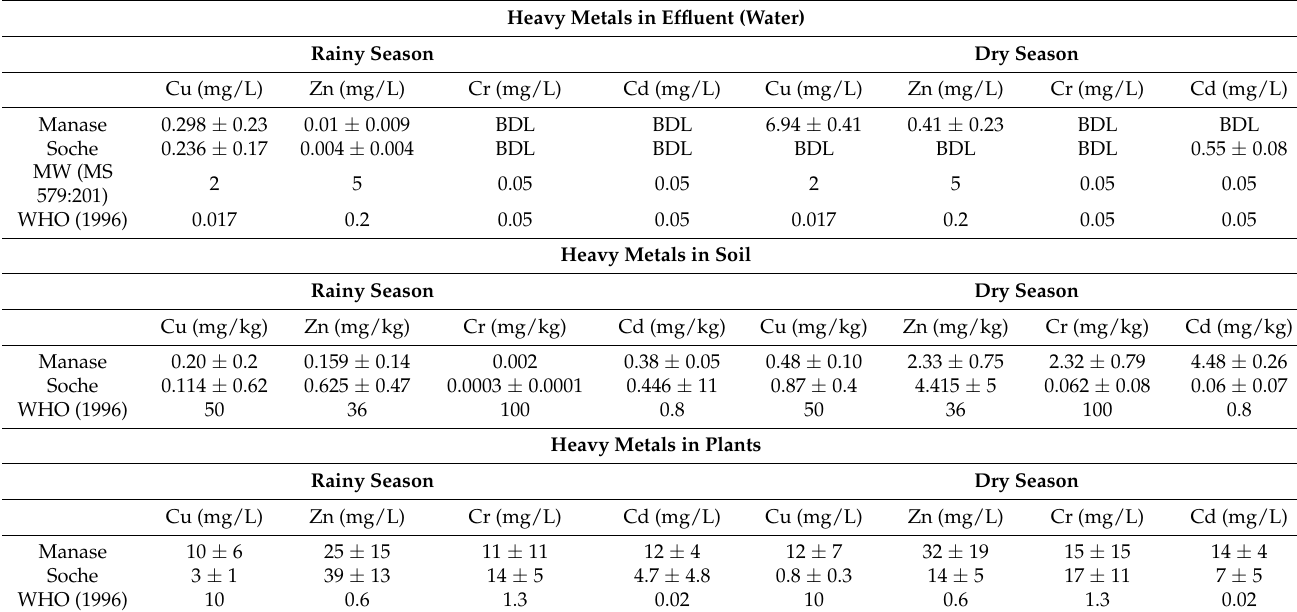
Table 2. Mean and standard deviation of heavy metals in water, soil, and plants at Manase and Soche